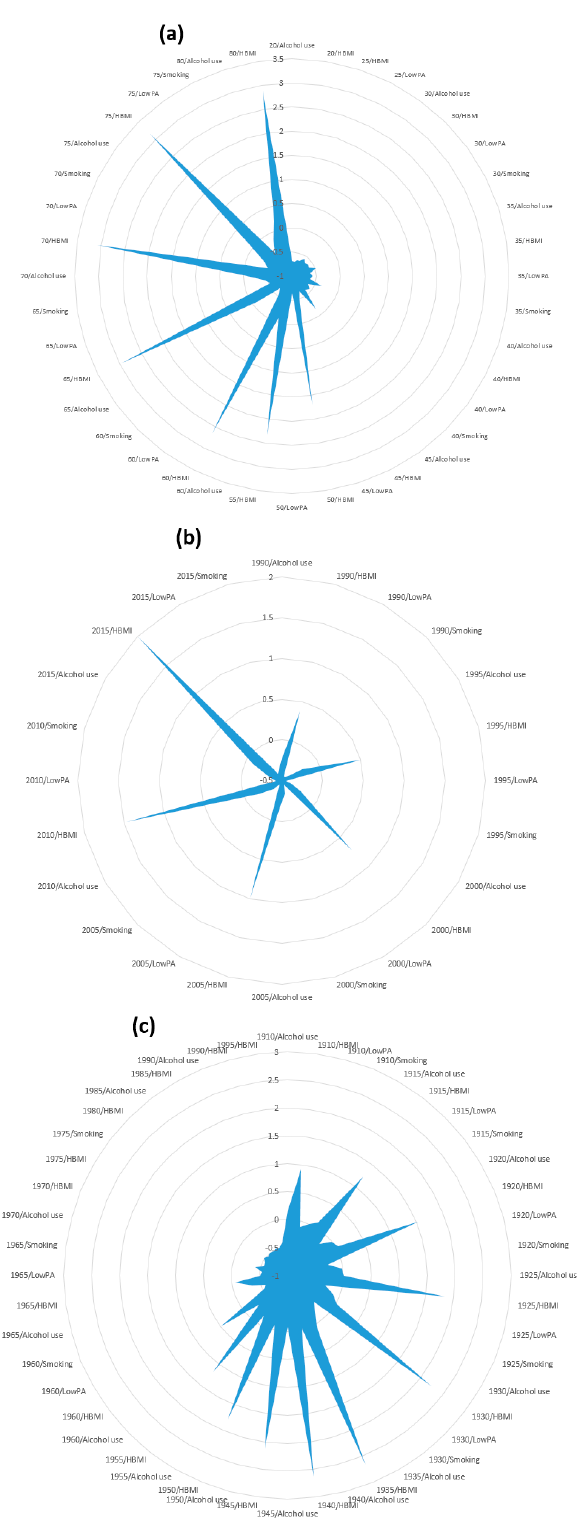
Figure 2. Random e ff ects of ( a ) age, ( b ) period, and ( c ) cohort interaction with di ff erent risk factors on Figure 2. Random effects of (a) age, (b) period, and (c) cohort interaction with different risk factors on mortality rates (MRs) using hierarchical age–period–cohort (APC) mortality rates (MRs) using hierarchical age–period–cohort (APC) model.